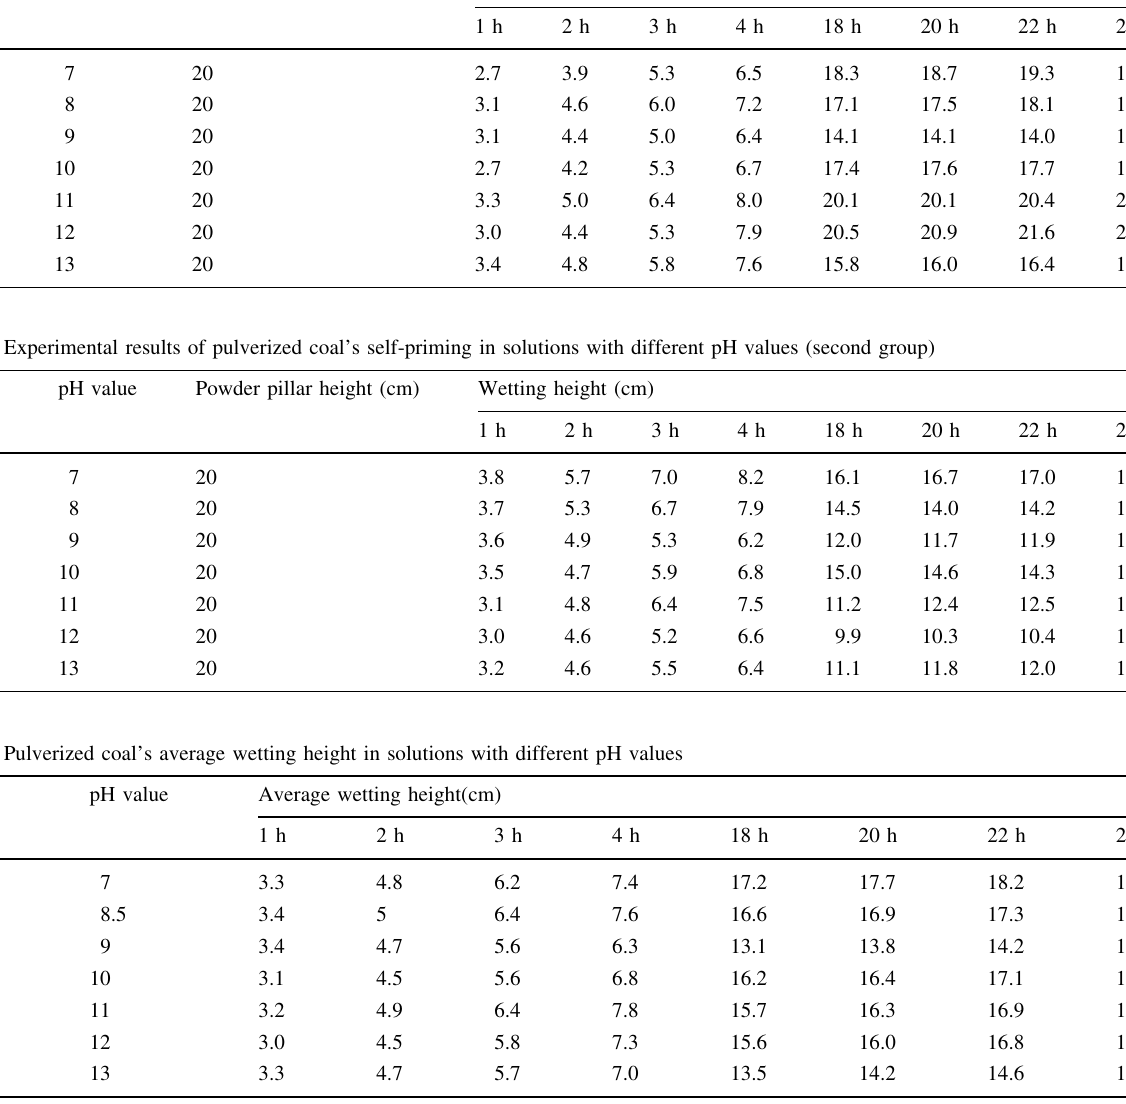
Table 1 Experimental results of pulverized coal’s self-priming in solutions with different pH values (first group) Coal no.